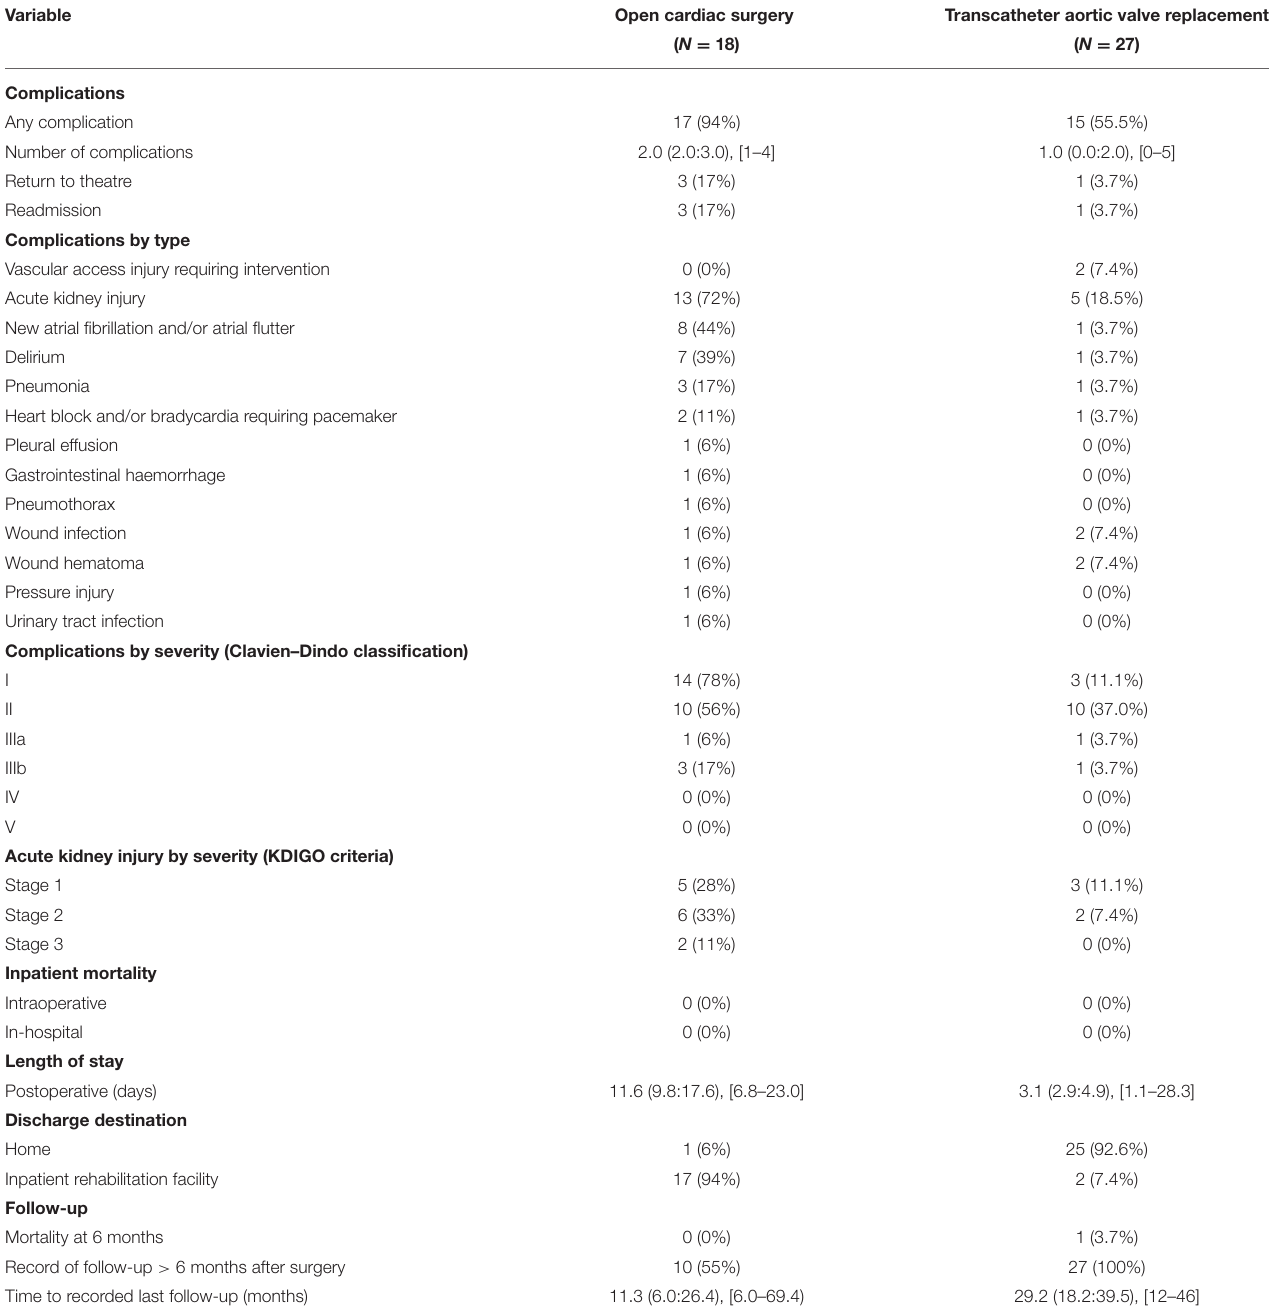
TABLE 7 | Complications, inpatient mortality, length of stay and follow-up of nonagenarians undergoing open cardiac surgery and transcatheter aortic valve replacement.